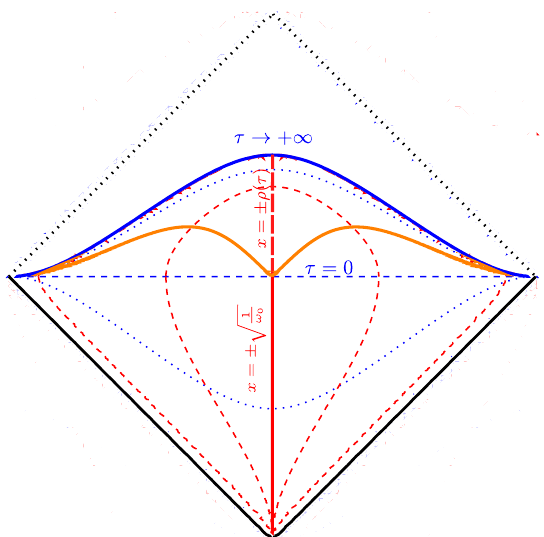
Figure 13. Penrose diagram for emergent space-time when ! 0 = 1 p ! 1 = 1. Blue dotted lines 2 are constant (cid:28) lines; specially, (cid:28) = 0 when the abrupt quench occurs are plotted in blue dashed line; (cid:28) ! 1 i.e. in(cid:12)nite future is plotted in blue solid line. Red dashed lines are constant x lines. q 1 Special values of x , x = (cid:6) and x = (cid:6) (cid:26) ( (cid:28) ), is plotted in thick red solid line and thick red ! 0 dashed line, respectively. The two sides of these lines are di(cid:11)erent disconnected space-times where the (cid:13)uctuations of the left and right fermi surface propagate. The orange solid lines demarcate the regions in which constant x lines are spacelike from those where they are time-like.